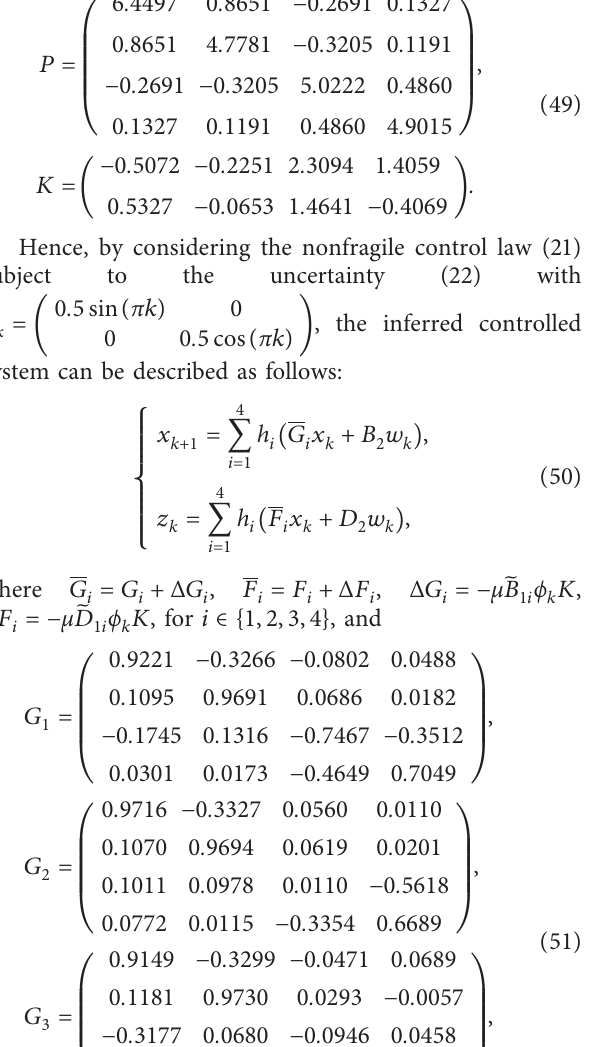
Figure 8: Control signal u